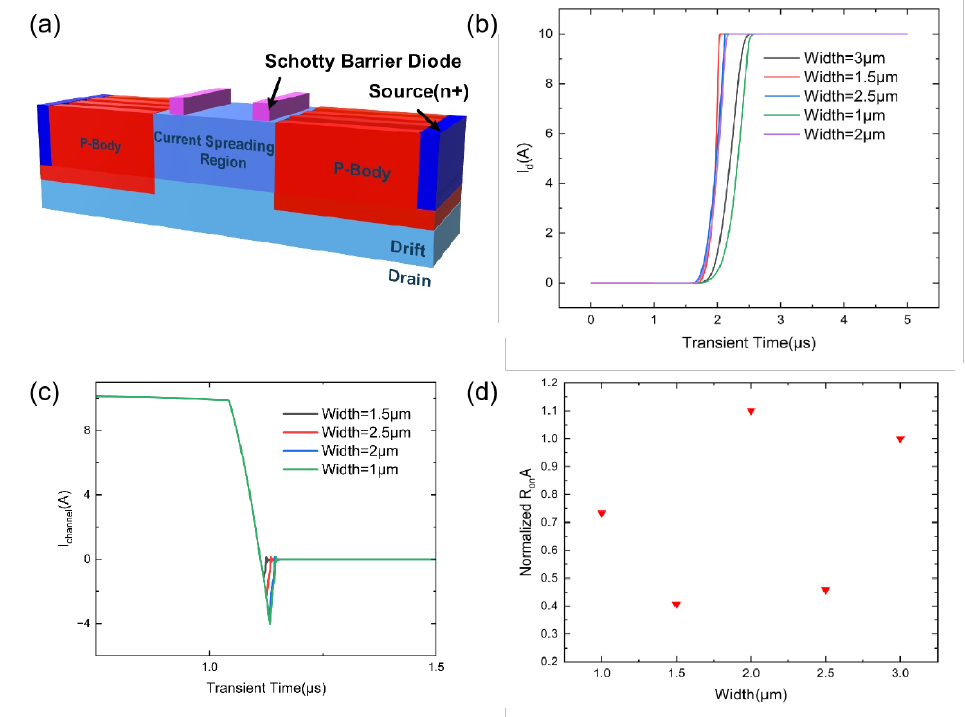
Figure 5. ( a ) New SBD structure with two crosswise regions; ( b ) Turn-on performance with different SBD Widths; ( c ) Reverse recovery current with different SBD Widths; ( d ) Turn-on Normalized R on